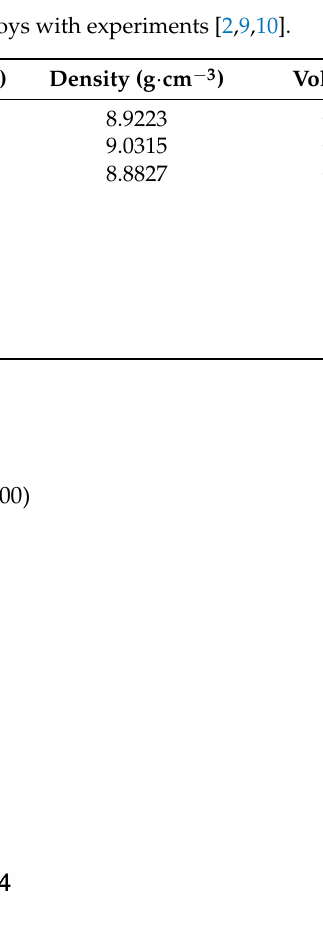
Figure 2. Simulated XRD patterns of Cu–Ni alloy crystal in the 2 θ = 42–54° range. The dashed lines indicate the position of the (111) and (200) fcc reflection for pure copper and pure nickel, the copper (Cu) is used for anode type, λ = 0.1540562 nm.